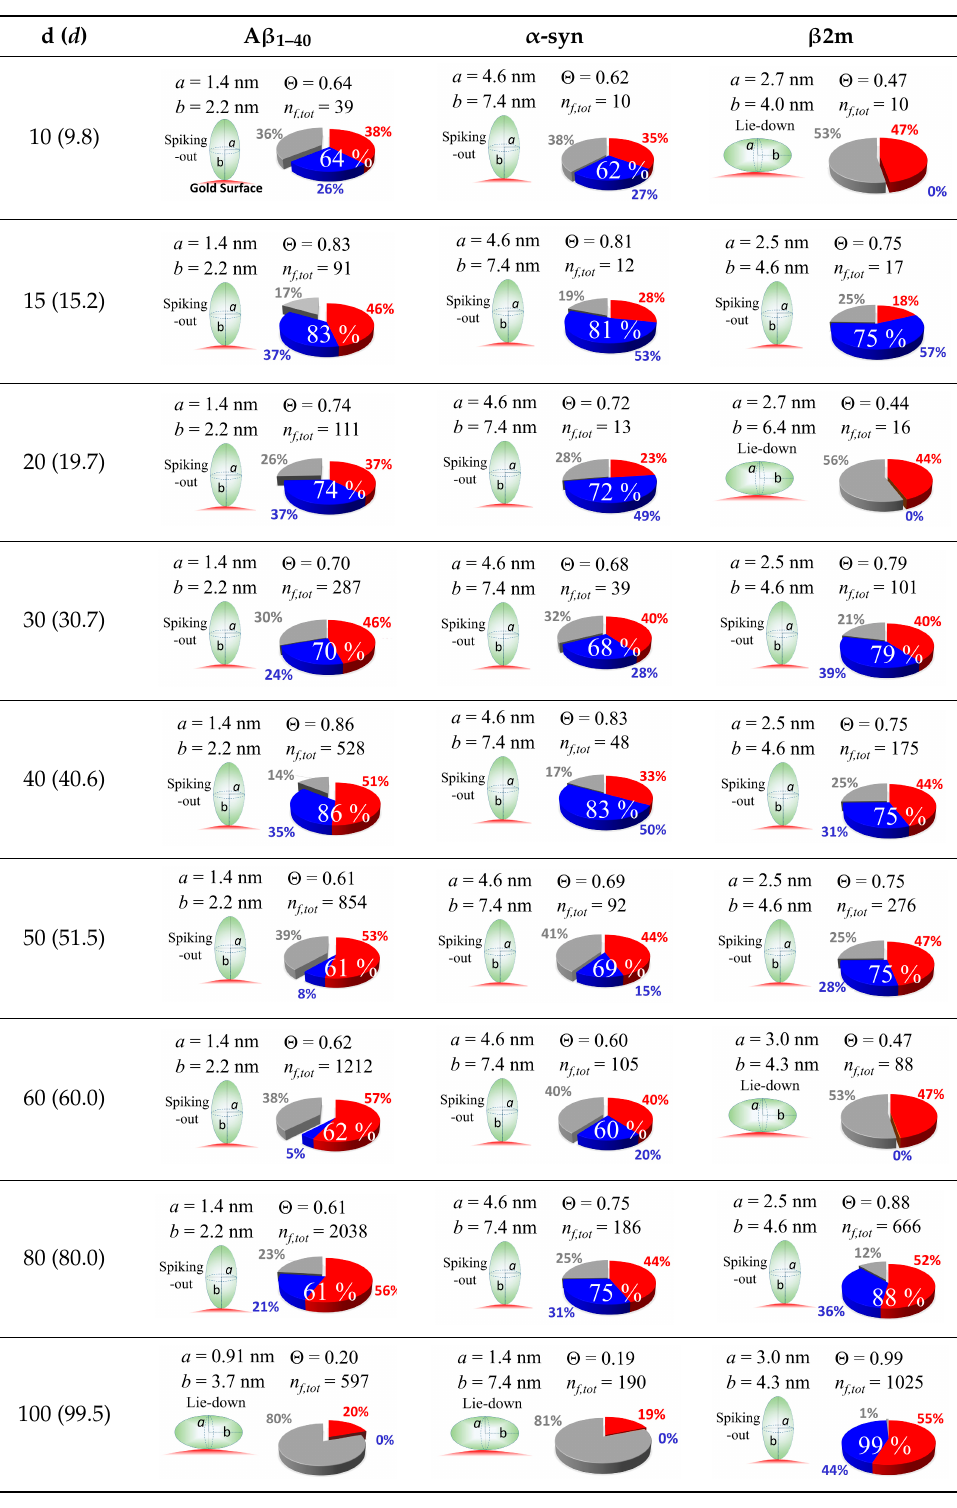
Table 2. In each box, optimized axial length of a prolate ( a and b ), the sketches of orientation of adsorption, n f ,tot (see Equation (3)), and circular graph indicating % of occupied surface area by adsorption (first layer in red, second layer in blue, and unoccupied in gray) for A β 1–40 , α -syn, and β 2m as a function of gold size d (and d ) nm.